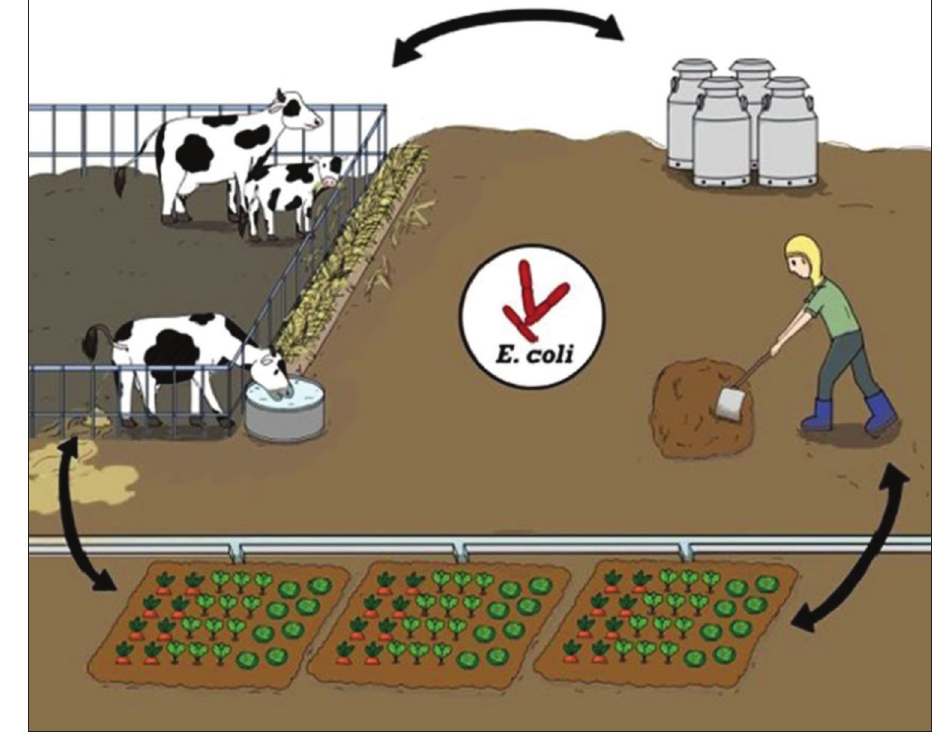
Figure-3: Circulation of carbapenem-resistant Escherichia coli between animals, environment, and humans in dairy farm (picture by Thamonphan